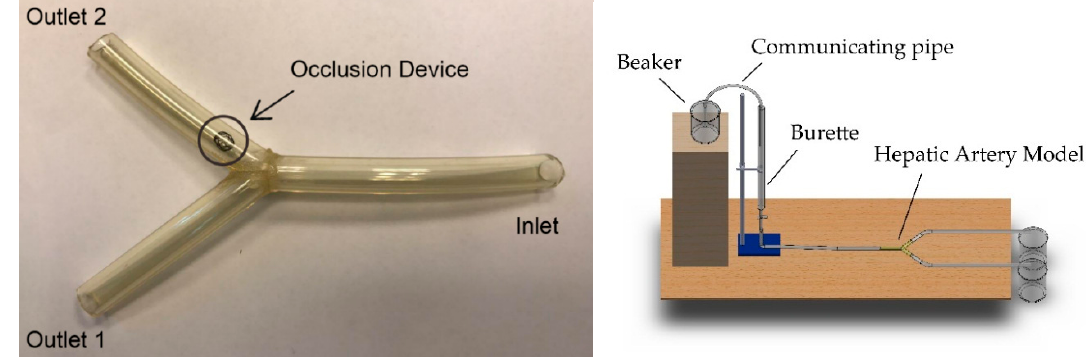
Figure 6. Hepatic artery model ( left ) and occlusion experiment setup ( right ).